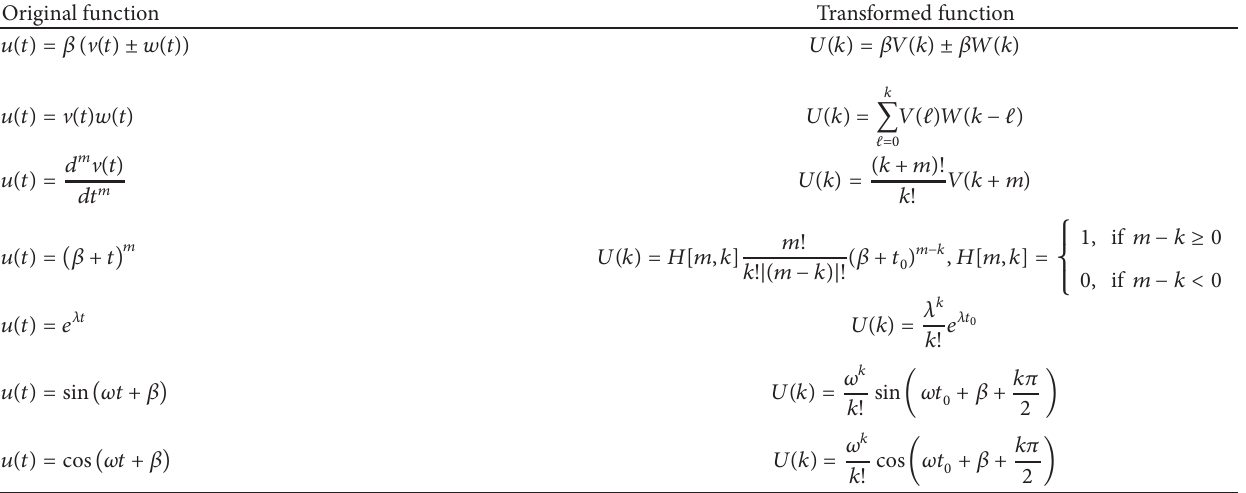
Table 1: Some fundamental operations of